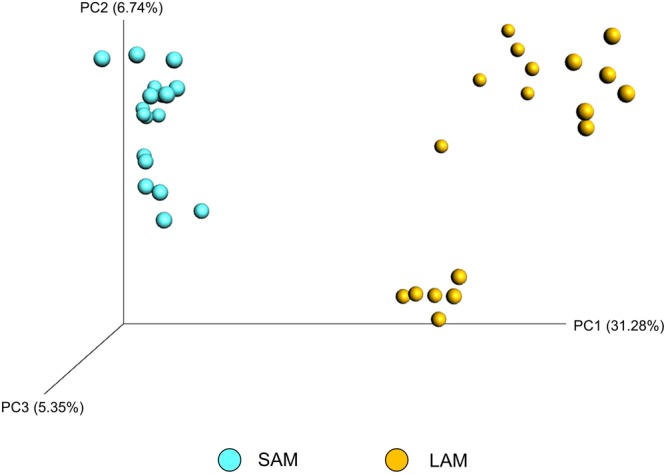
Principal coordinate analysis (PCoA) of the unweighted UniFrac distances for SAM and LAM samples. The percent variation explained by each principal coordinate is indicated on the axes. Original rumen samples are excluded. LAM, liquid-associated microbes; SAM, solid-associated microbes. N = 18 for both sample types.